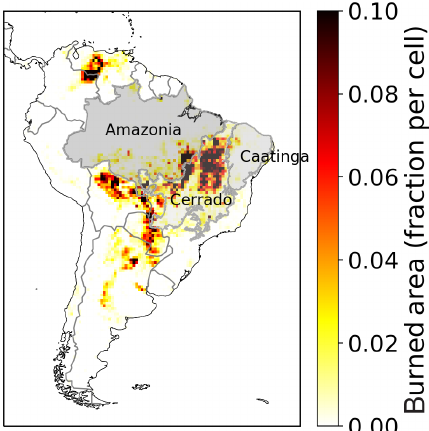
Figure 1. Overview of the mean annual burned area in Brazil from 2005 to 2015 (van der Werf et al., 2017; Giglio et al., 2013) and the biomes Amazonia, Cerrado, and Caatinga (IBGE, 2019; Harvard,